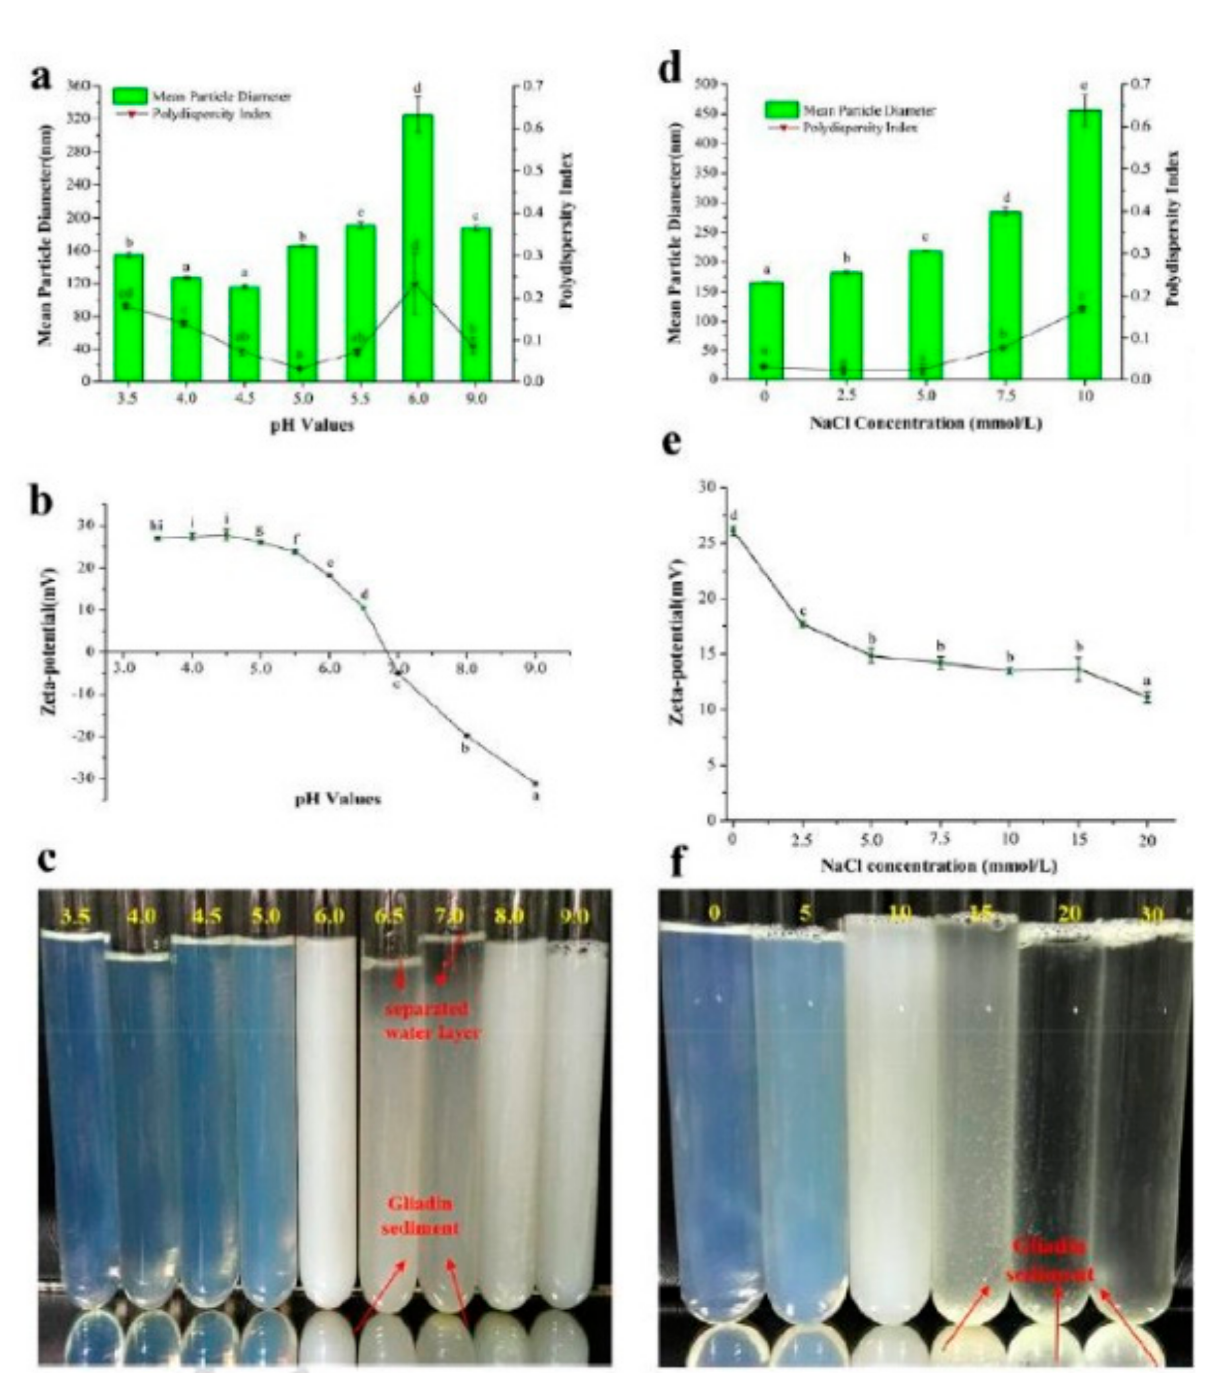
Figure 13. Changes in the size and zeta potential properties of gliadin nanoparticles with different pH ( a , b ) and NaCl concentrations ( d , e ). Visual images of the gliadin nanoparticles at different pHs ( c ) and NaCl concentrations ( f ). Reprinted with permission from ref. [90]. Copyright 2018 Taylor and